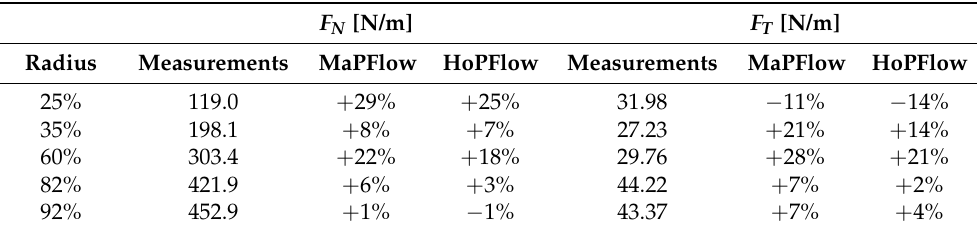
Table 8. Radial distribution of normal and tangential forces. Comparison between experimen- tal measurements and computational predictions. Reference values correspond to experimental measured values.